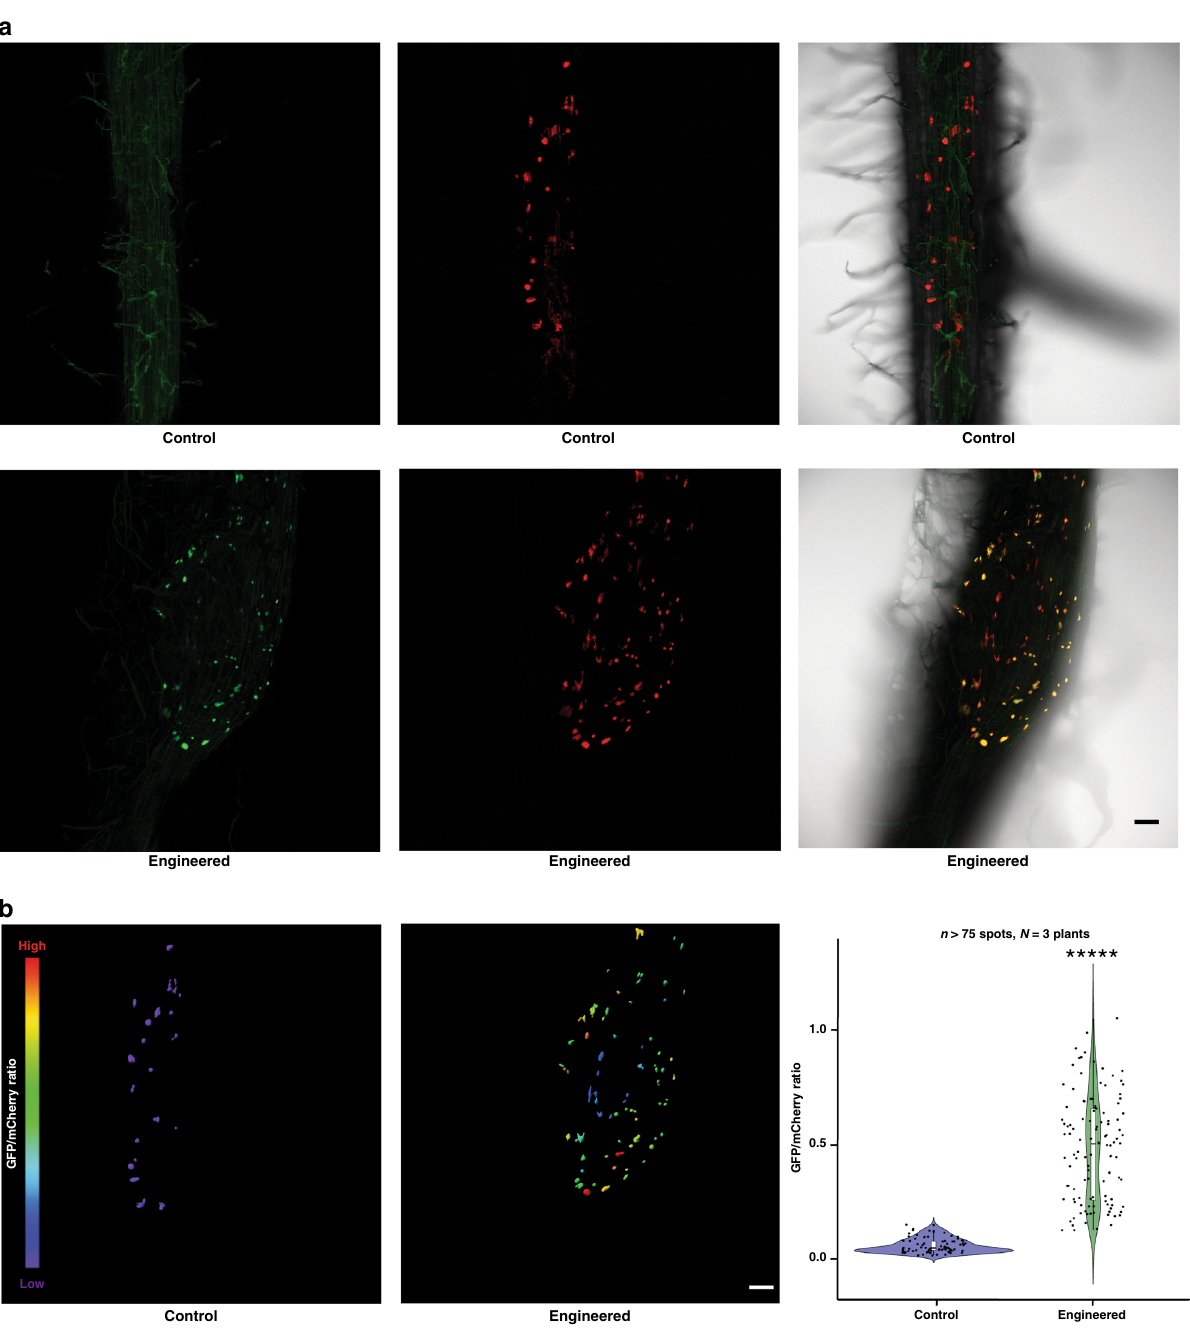
Fig. 4 Fluorescent microscopy of rhizopine-mediated transkingdom signalling. a Confocal fl uorescence microscopy images showing green fl uorescent protein (GFP) fl uorescence of Rlv3841::mTn7-mCherry/pOPS0761 biosensor [with constitutive mCherry fl uorescence] on the surface of T 1 barley seedlings transformed with empty vector (control) or IdhA-MosB together (engineered). Z-stack projections of green fl uorescence channel (left, GFP), red fl uorescence channel (middle, mCherry) and all channels merged (right, bright- fi eld) are shown (scale bars, 100 µ m). Images shown are representative of experiments repeated two independent times. b Three-dimensional images of GFP/mCherry mean intensity ratios in Rlv3841::mTn7-mCherry/pOPS0761 biosensor on the surface of T 1 barley seedlings transformed with empty vector (left, control) or IdhA-MosB together (middle, engineered) (scale bars, 100 µ m). Cool colours (purple) indicate low GFP/mCherry intensity ratio, and warm colours (red) indicate a high GFP/mCherry intensity ratio. Violin plot of GFP/mCherry ratios in the biosensor colonies (right; n > 75 spots; N = 3 plants). Asterisks signify statistical signi fi cance (Wilcoxon ’ s signed-rank test, P = 1.30 × 10 − 14 ). Images shown are representative of experiments repeated two independent washed with running buffer and eluted with running buffer containing 10 mM and stored at − 80 °C. Cell pellets were thawed on ice and resuspended in 15ml maltose. extraction buffer (MBPTrap binding buffer (20 mM Tris-HCl, 200mM NaCl, Purity of puri fi ed proteins was assessed by sodium dodecyl sulfate- polyacrylamide gel electrophoresis analysis and proteins were quanti fi ed using a Qubit 2.0 Fluorometer (Thermo Fisher) according to the manufacturer ’ s at 4°C. The clari fi ed lysate was fi ltered (0.45 μ m) and loaded onto a 1 ml MBPTrap instructions. HP column on an AKTA Basic 10 (GE Healthcare Life Sciences). The column was